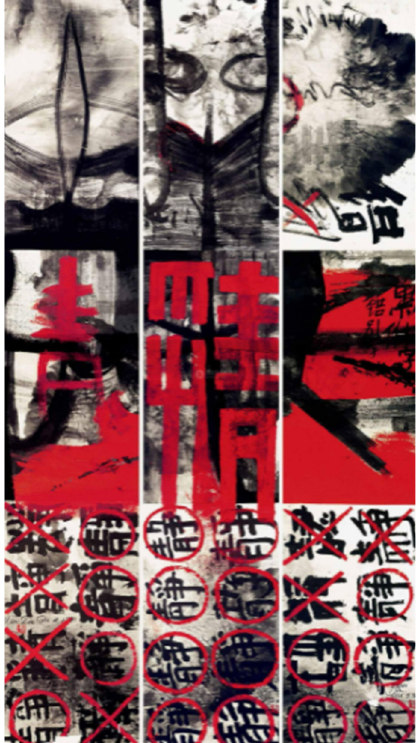
Figure 1. “Drama of the Hybridization of Two Cultural Forms” by Wenda Gu. Ink on paper and white-silk-framed vertical shaft. First published in Fine Arts , 1986, vol. 1. Picture from the Center for Visual Studies, Peking University.